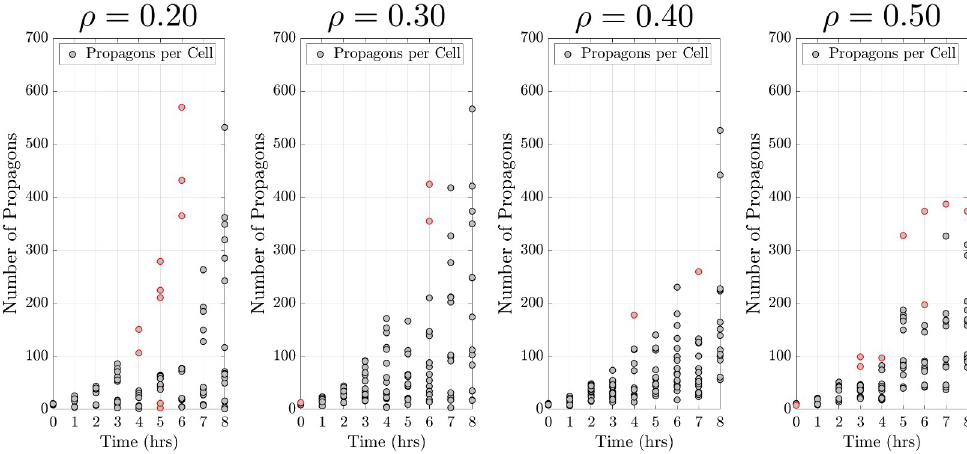
Fig 3. Simulated data. The simulated data was generated using a replication rate of λ = 0.70 hr − 1 and four different transmission biases ( ρ ). Samples were generated per experimental hour at a rate of 16 samples per hour. Data points outlined in red were determined to be outliers by the IQR